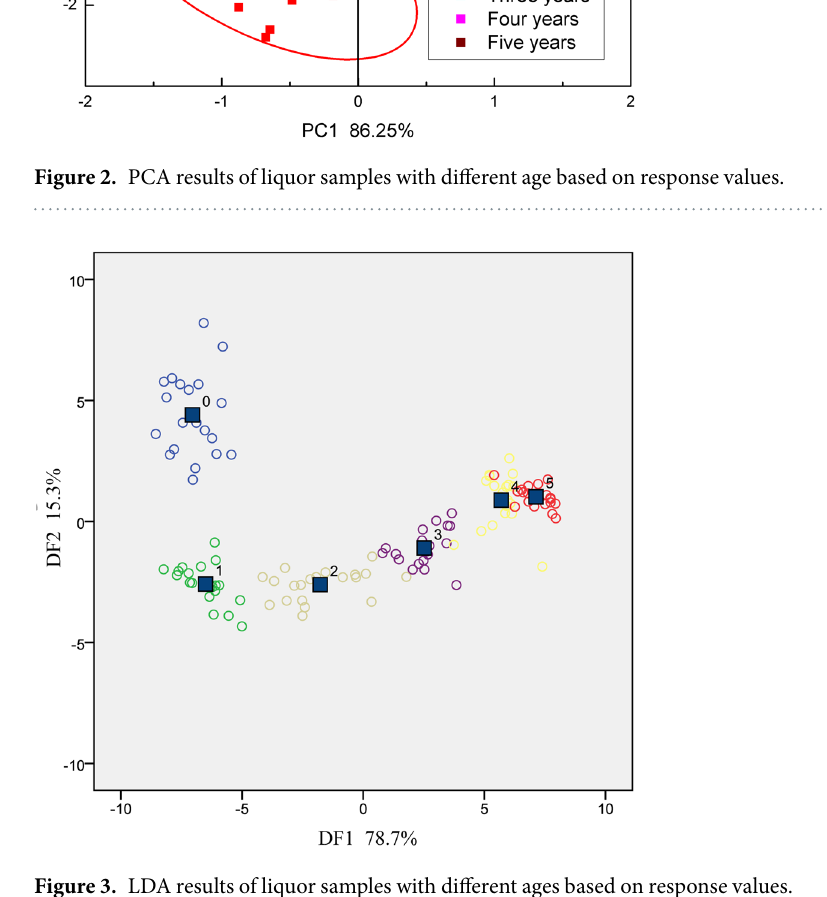
Figure 3. LDA results of liquor samples with different ages based on response